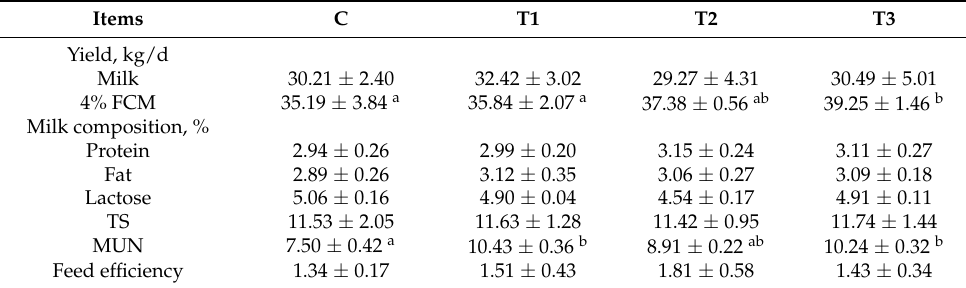
Table 2. Effects of dietary BM1259 on milk yield and composition in lactating dairy